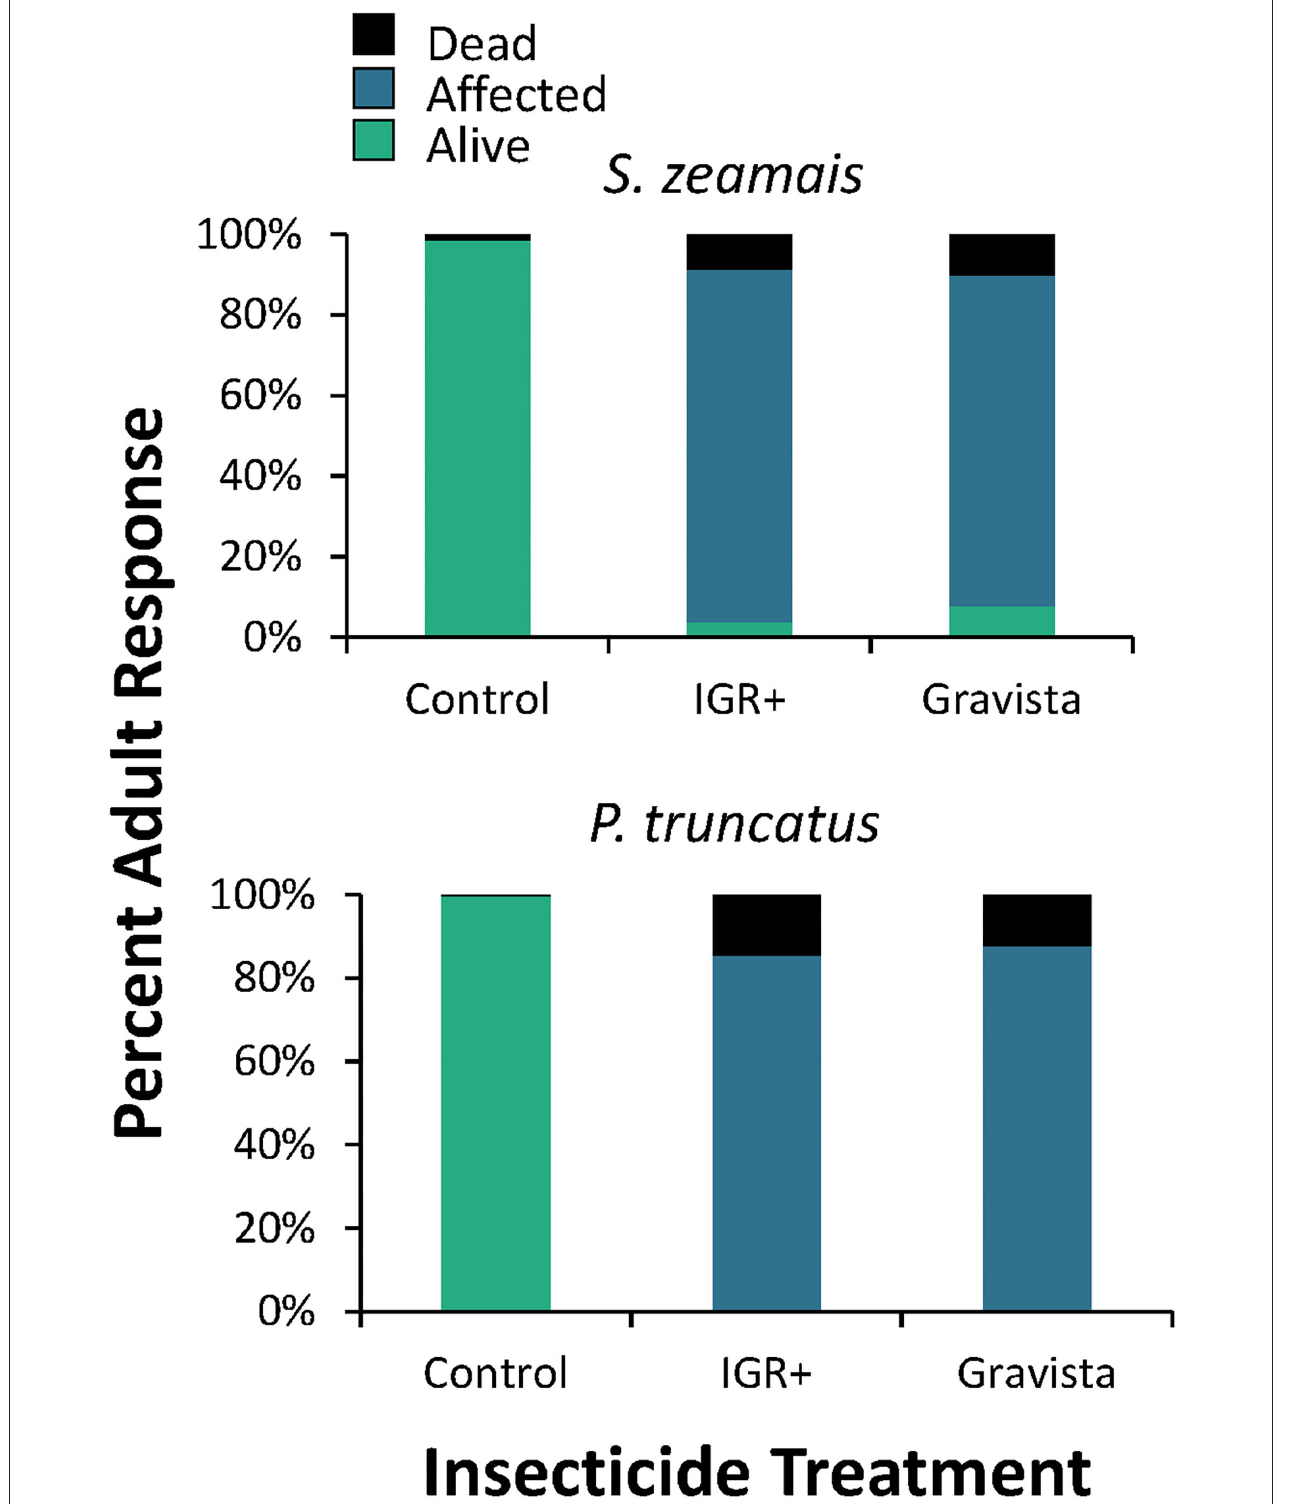
FIGURE 1 | Overall percent mortality induced by an existing (methoprene + deltamethrin, IGR + ) and novel (methoprene + deltamethrin + synergist, Gravista) commercial formulation of insecticide when applied against S. zeamais (top panel) and P. truncatus (bottom panel) on concrete arenas after exposure for 4–168h, resulting in alive (green), affected (blue), or dead (black) individuals.